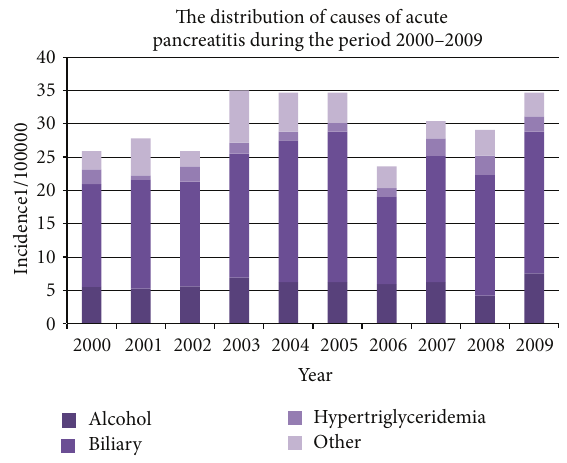
Figure 4: The distribution of the commonest etiologies of acute pancreatitis in the observed